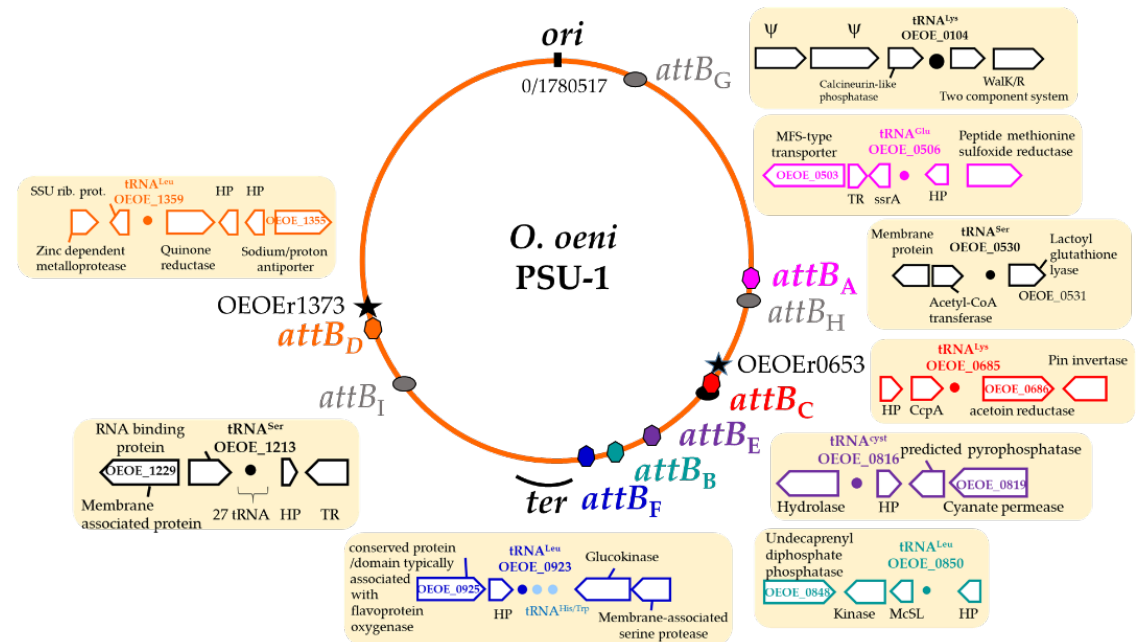
Figure 1. Site-specific recombination of temperate oenophages in O. oeni. The locations of the attachments sites used by prophages (color) and phage remnants (gray) are shown as a generalized chromosome backbone based upon the PSU-1 genome. Locations of the oriC , Ter site-containing region and rRNA loci (stars) are indicated. Genes flanking all attB sites are